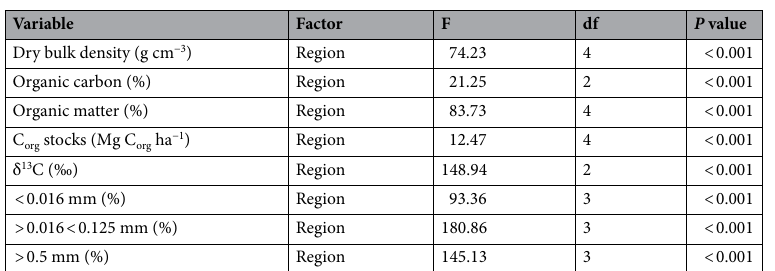
Table 3. Results of the Generalized Linear Models (GLM) testing for significant effects of region (Alta Guajira, Media Guajira, San Andrés, Tayrona, Cartagena) on seagrass soil dry bulk density (g cm −3 ), soil organic carbon and content of sediment grain-sizes < 0.016 mm, > 0.0.016 < 0.125 mm and > 0.5 mm (%) in the Colombian